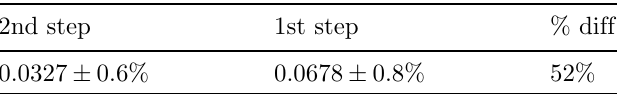
Table 7. 2nd and 1st step simulated doses in 10 (cid:4) 14 Gy/ pot, in position 1, cp_CIIC con fi guration. 2nd step 1st step % diff. 0.0678 ± 0.8% 52%